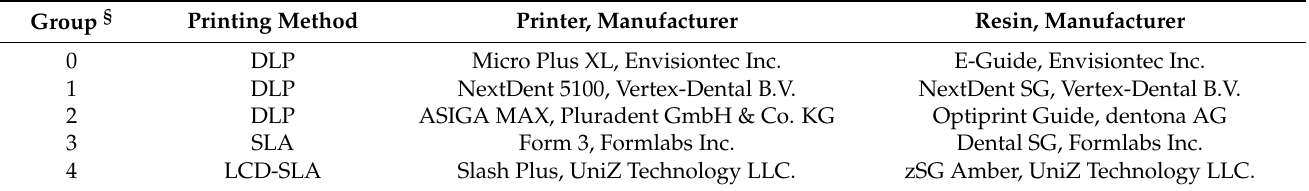
Table 1. Printers and resins used in this study, with details of the number of specimens per group and